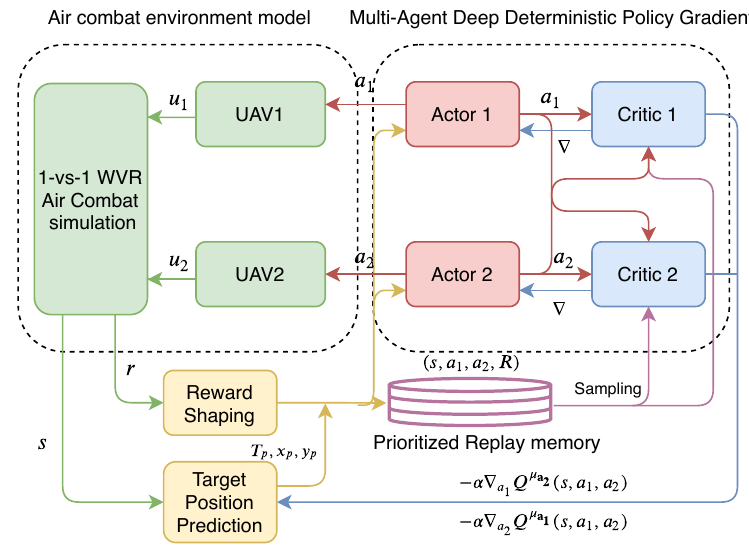
Figure 3. The overall framework of the maneuvering strategy generation algorithm. WVR: Within Visual